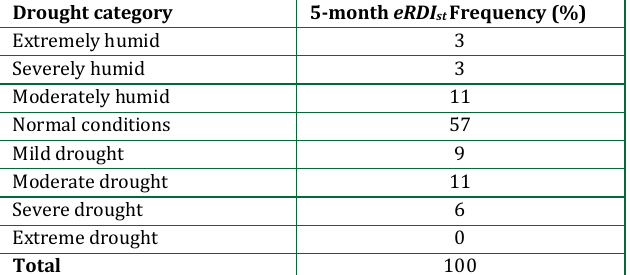
Table 2: 5-month eRDIst Frequency in percentages (%). Moderate agricultural droughts have the highest frequency.